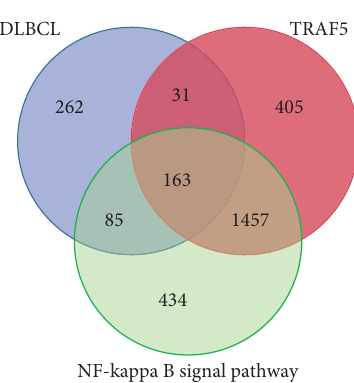
Figure 4: Intersection of miRNAs associated with DLBCL, TRAF5, and NF-kappa B signaling